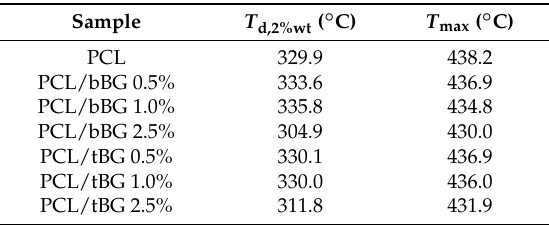
Table 3. Characteristic temperatures of thermal degradation of PCL and its